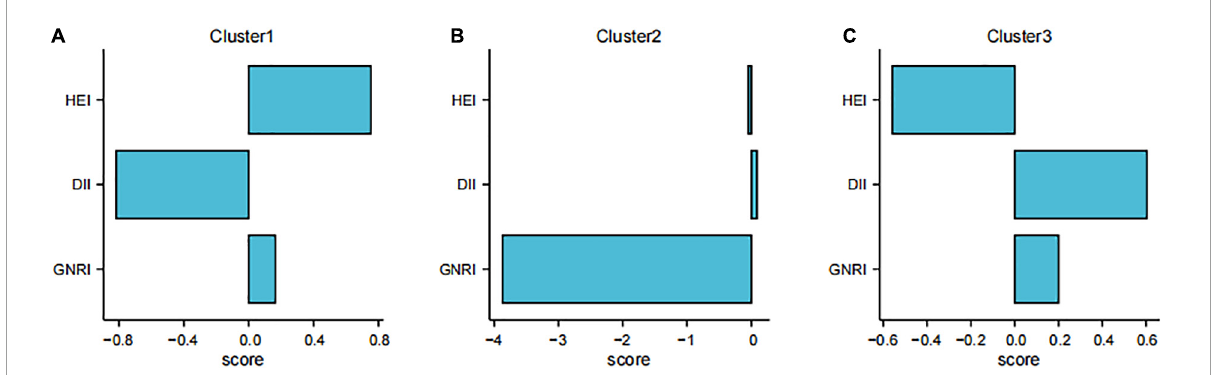
FIGURE3 Distribution of cluster centers for the three scores in different clusters. (A) Cluster 1 [higher healthy eating index (HEI), lower dietary inflammatory index (DII)]; (B) Cluster 2 [lower geriatric nutritional risk index (GNRI)]; (C) Cluster 3 (lower HEI, higher